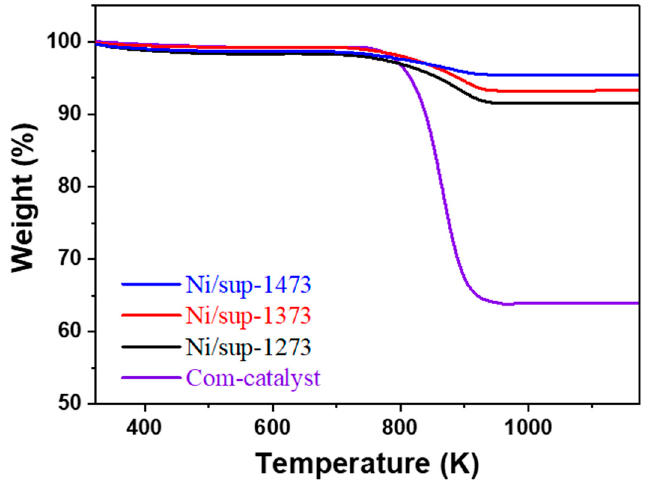
Figure 10. TGA curves after the SMR reaction under harsh conditions. Table 2. Strength of the catalysts used.